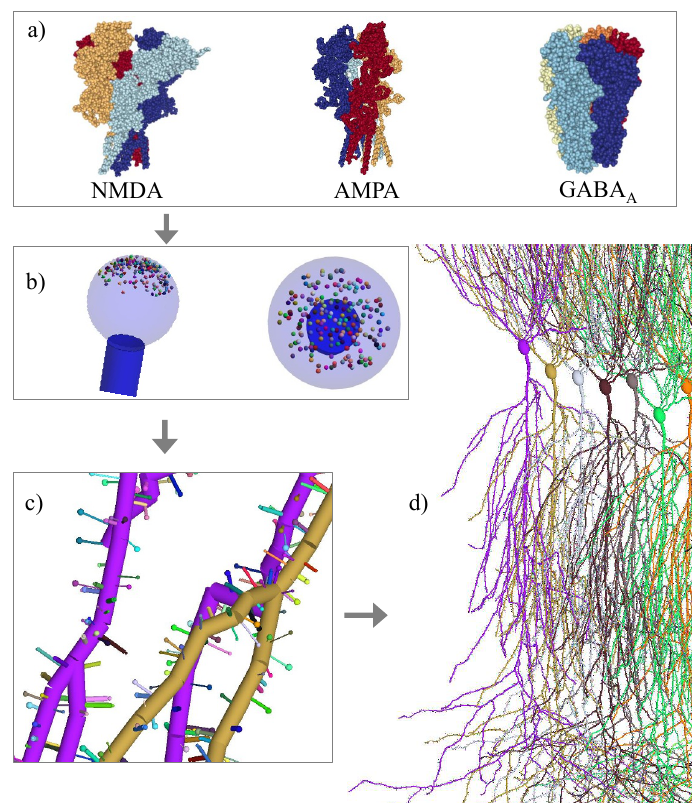
Figure 1. Organization of ionotropic receptors and spines on dendritic trees of neural cells: a) An atom- istic model of NR1a / 2b NMDA, GluA2 / 3 AMPA and GABA A receptor ( β 3 homopentamer). Di ff erent colors are used to represent four and five subunits of glutamate (NMDA, AMPA) and GABA A receptor. b) A head of dendritic spine with receptors randomly placed within the PSD. c) A dendritic segment of individual neurons with spines and receptors. d) A snapshot of CA1 pyramidal neuron network in the model of the rat